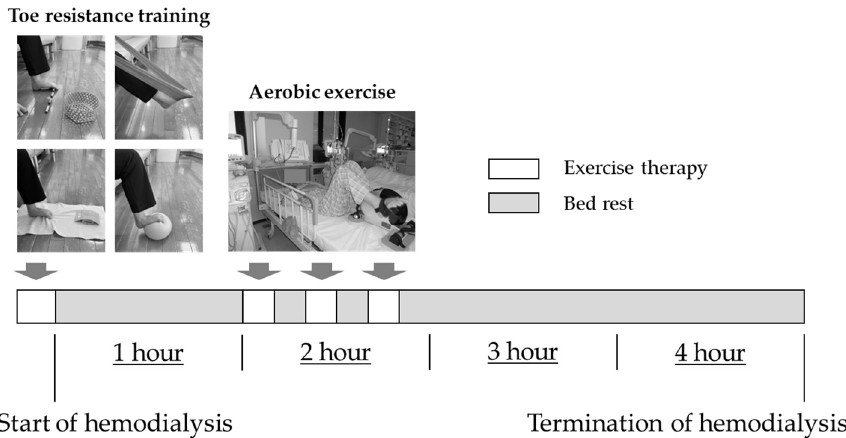
Figure 2. Exercise therapy protocol.